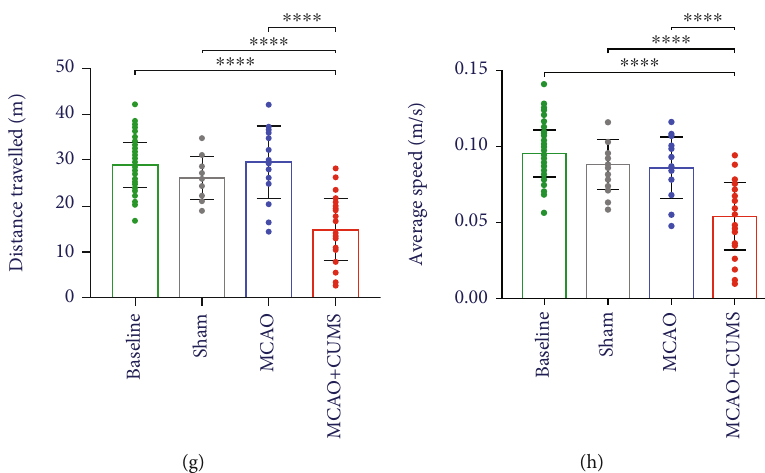
Figure 1: E ff ects of CUMS on the behaviors of MCAO rats. (a) The study schedule and behavioral testing time frames. (b) Representative heat maps of the immobility duration of each group in the OFT. (c) Dynamic variations in the weight of experimental subjects. (d) Changes in sucrose preference after a three-week stress period. (e) Pretreatment di ff erences in immobility between groups. (f) Rearing counts of each group in the OFT. (g) Variations in distance travelled after chronic stress. (h) Changes in average speed of subjects in various groups after a three-week stress period. One-way ANOVA followed by Tukey ’ s multiple comparison tests and repeated measures ANOVA were used for analysis. n = 21 per group. ∗ p < 0 : 05 , ∗∗ p < 0 : 005 , ∗∗∗ p < 0 : 0005 , and ∗∗∗∗ p < 0 : 0001